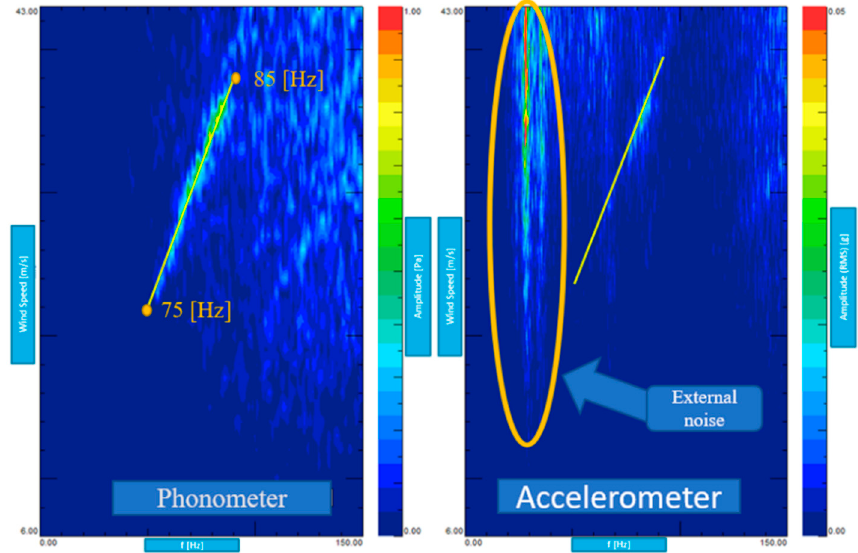
Figure 6. Accelerometers and phonometer comparison for rigid neck.